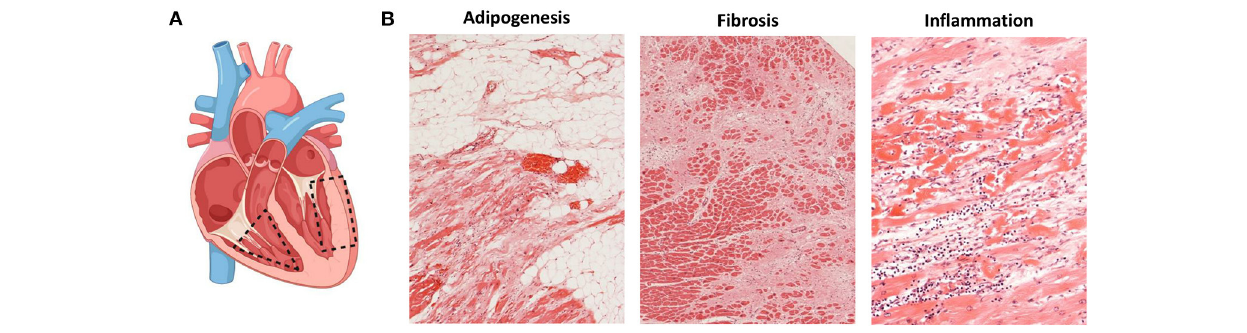
FIGURE 1 | Histopathological changes in ACM. (A) Most affected heart regions in ACM. In the right ventricle, structural changes mostly affect areas of the inflow tract, the outflow tract and the apex known as the triangle of dysplasia (dashed triangle). When the left ventricle is affected, structural changes are observed in the inferior and inferolateral walls (dashed rectangle); created with BioRender.com. (B) Histopathological changes observed in ACM namely adipogenesis (left), fibrosis (middle) and presence of inflammatory infiltrates